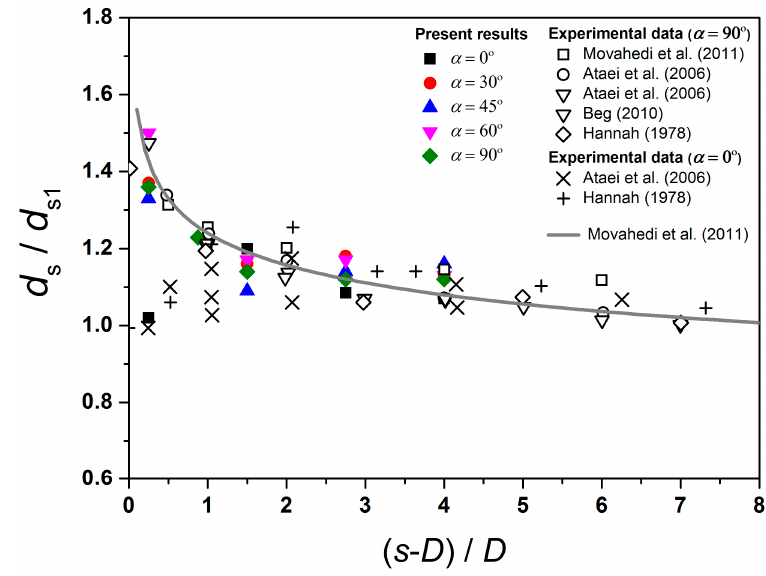
Figure 11. Maximum scour depth according to the gap between two cylinders.